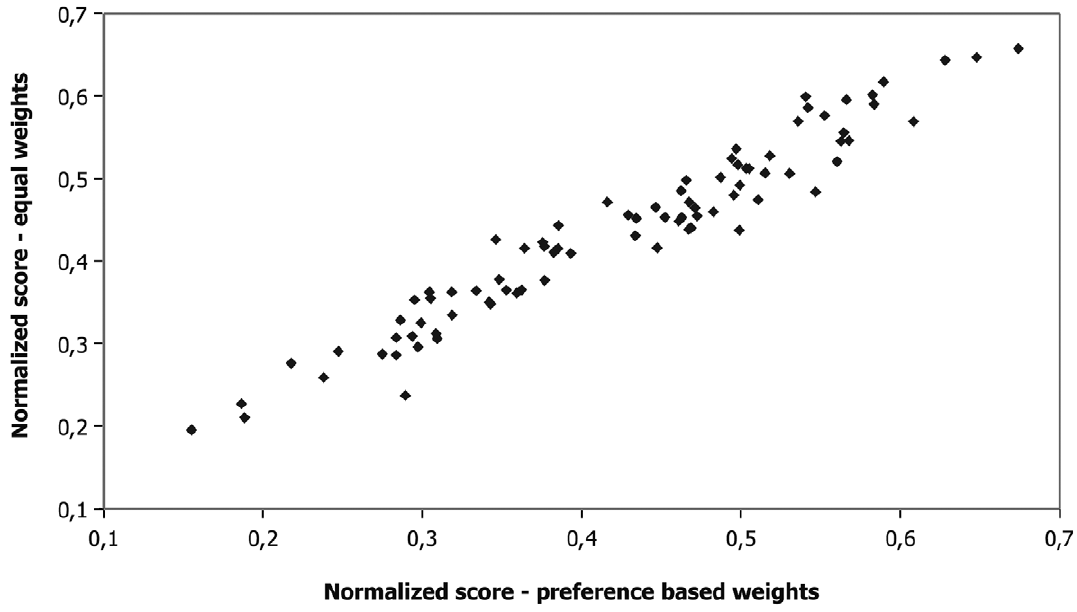
Figure 4. Comparison of normalized scores using preference-based weights and equal weights.